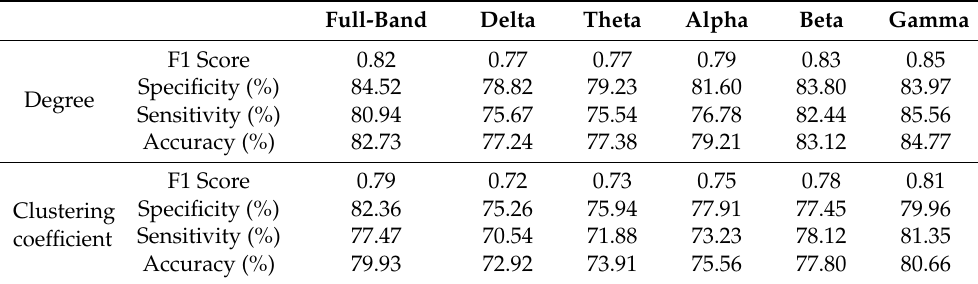
Table 1. This table shows the classification results of degree and clustering coefficient.